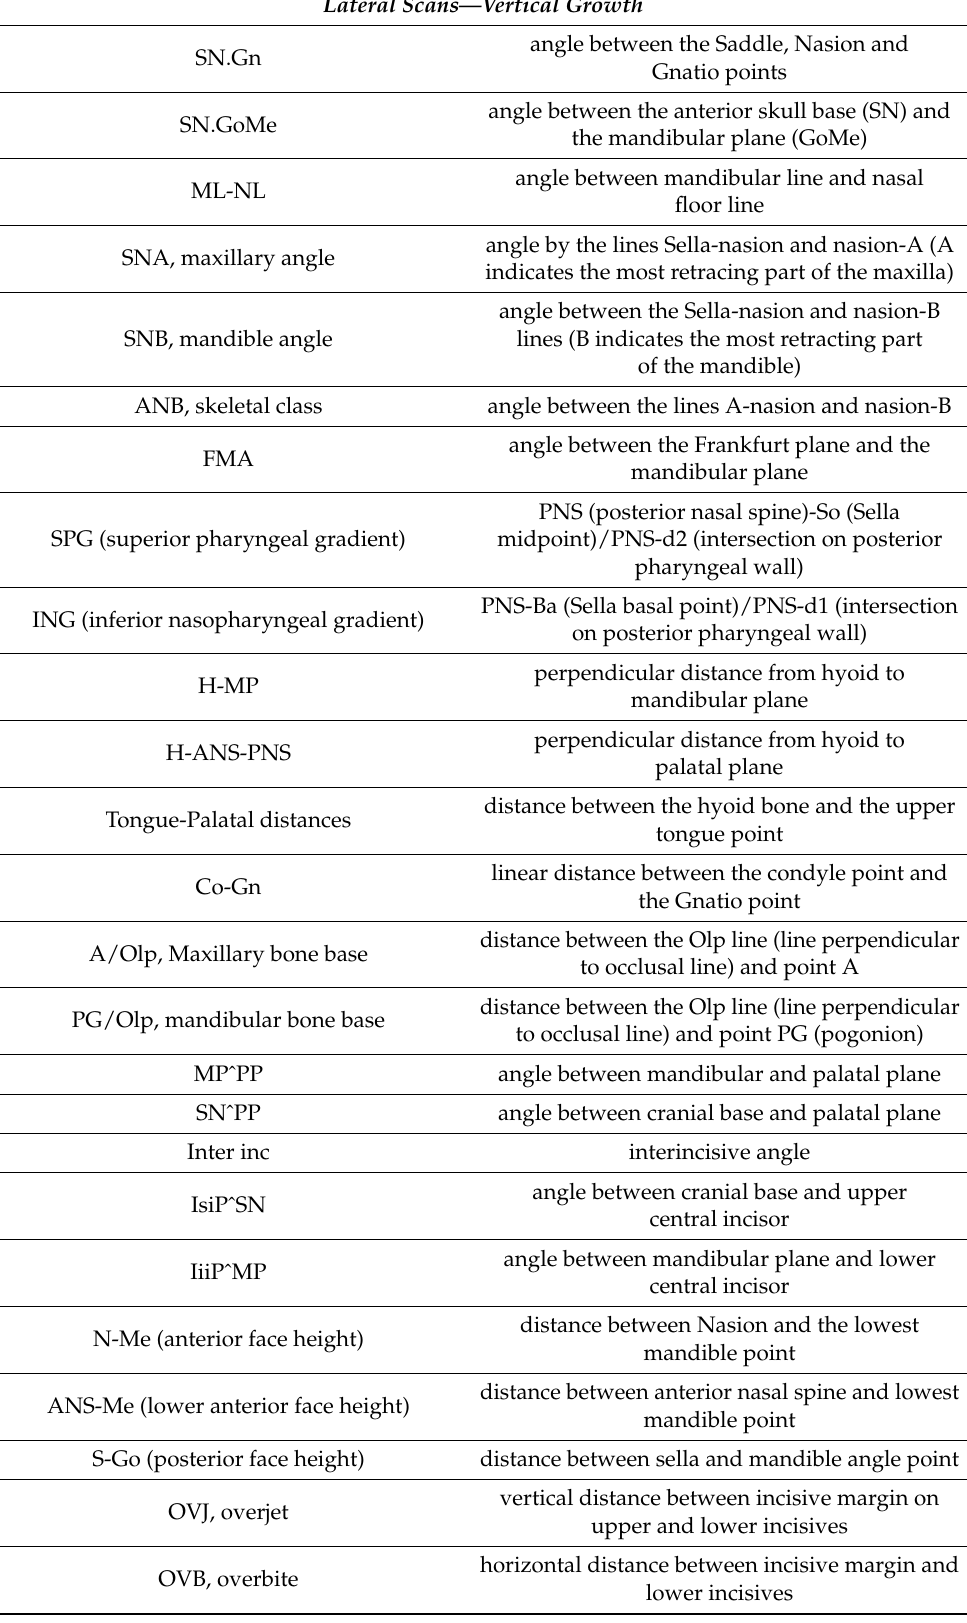
Table 2. Effects of RME on airway dimensions and volume: lateral scans vs. vertical